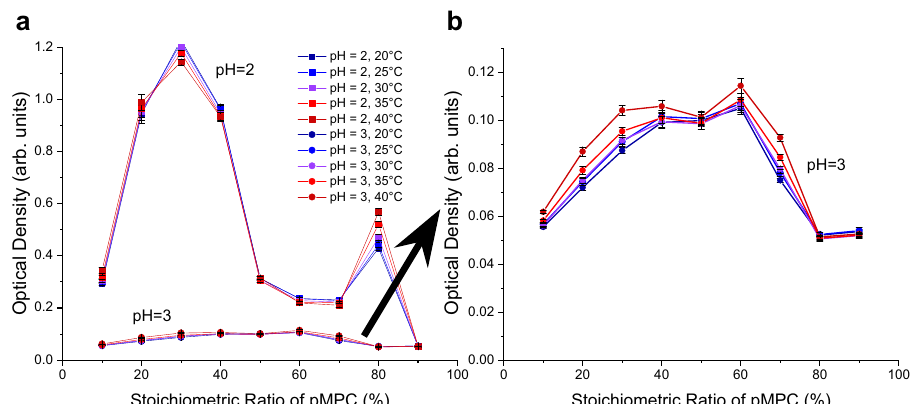
Fig. 4 Stoichiometry of pMPC:pAA vs. turbidity at pH 2 (squares) and 3 (circles), plotted over a temperature range from 20 – 40 ∘ C (blue to red, respectively). a Data from the pH 2 samples demonstrate a peak value at a 30:70 mixing ratio. By comparison, the pH 3 data at the bottom of graph